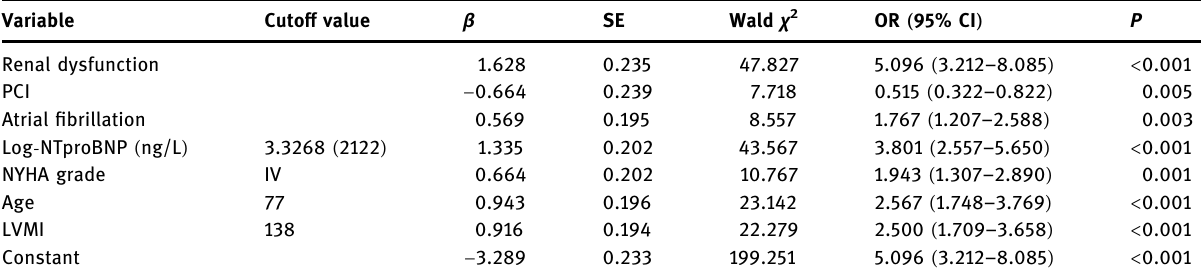
Table 2: Multivariate logistic regression results after conversion of variables